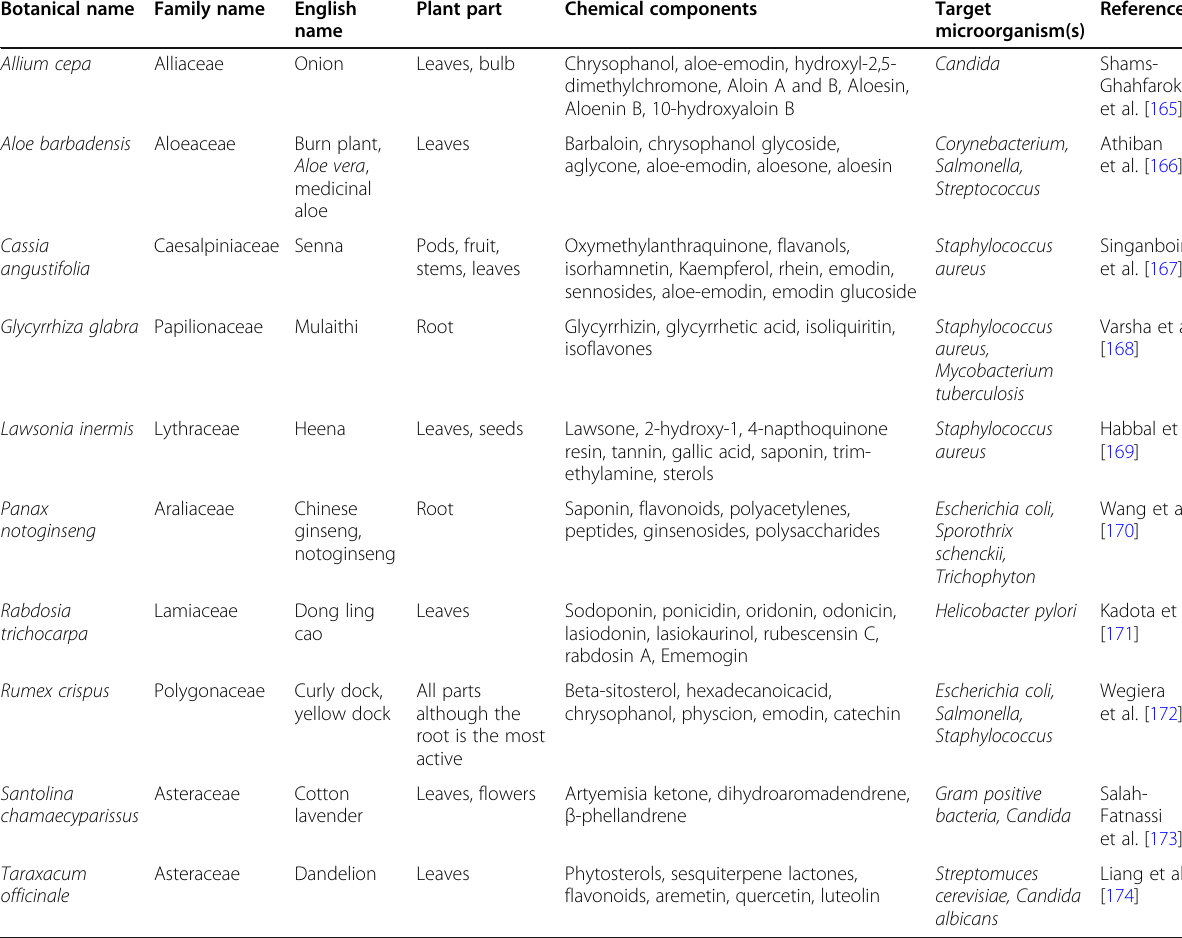
Table 5 Chemical components and target microbial group of some medicinal